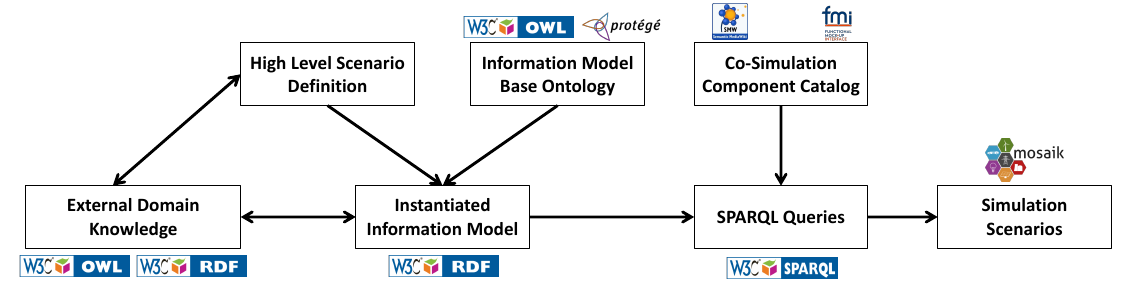
Figure 3. Overview of the simulation planning